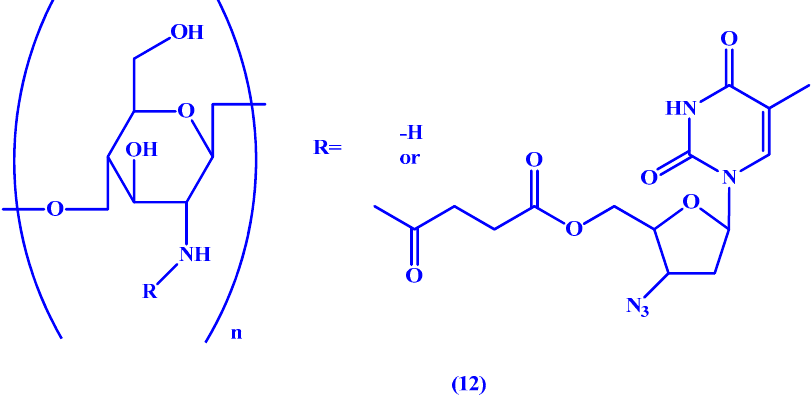
Figure 6. Chemical structure of the AZT-suc-COS prodrug 12 .